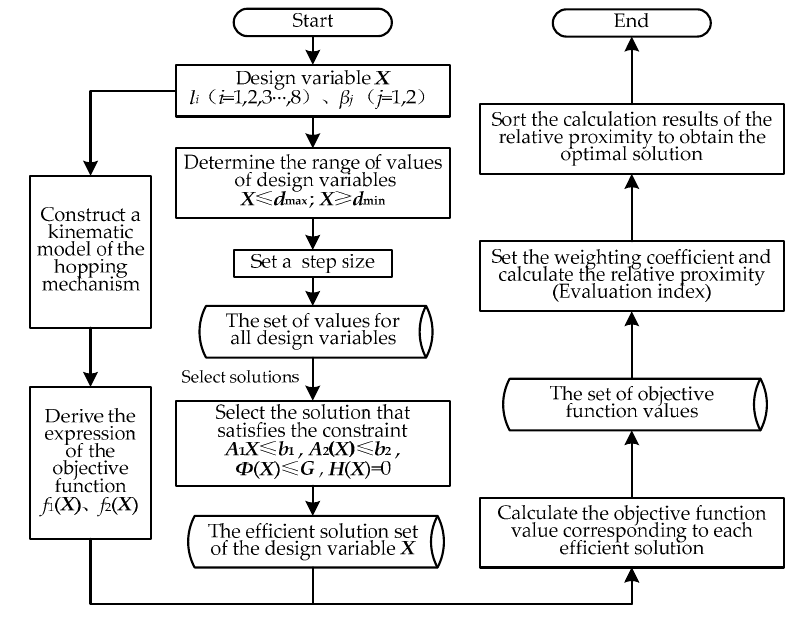
Figure 7. The flow chart of the optimization. Table 2. Optimization results of the hopping mechanism dimensions.